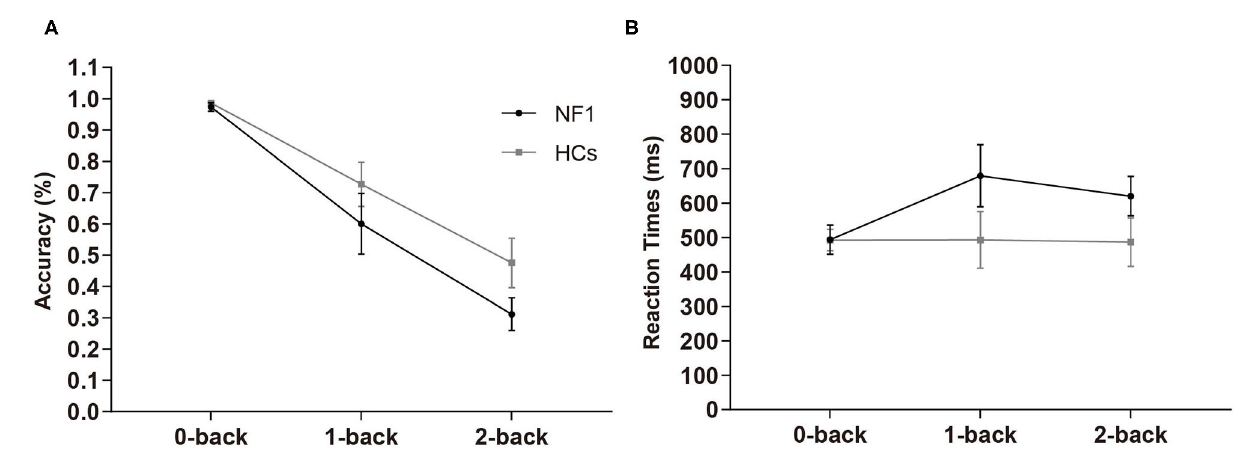
Frontiers in Psychology |